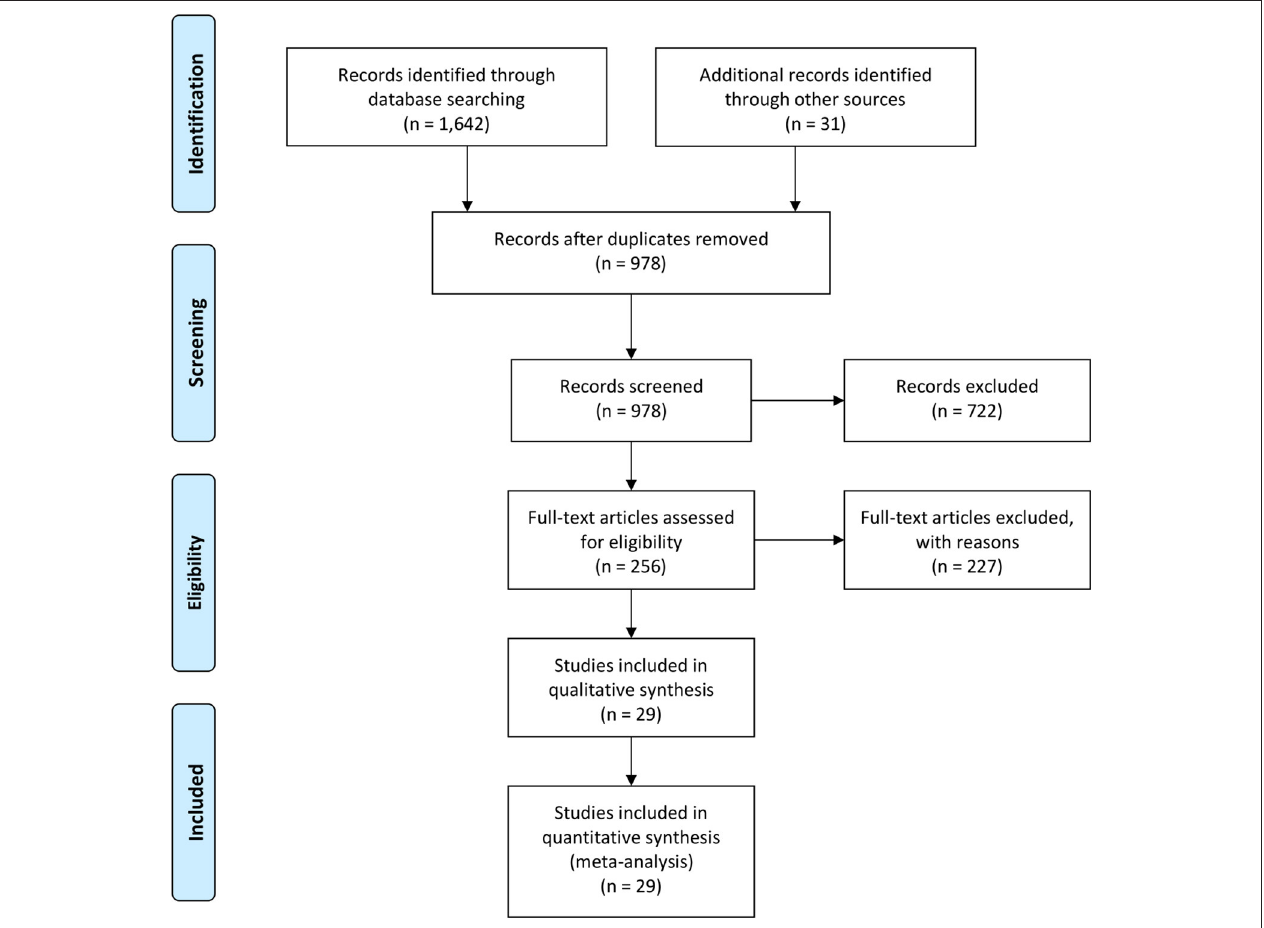
FIGURE 1 | PRISMA flow